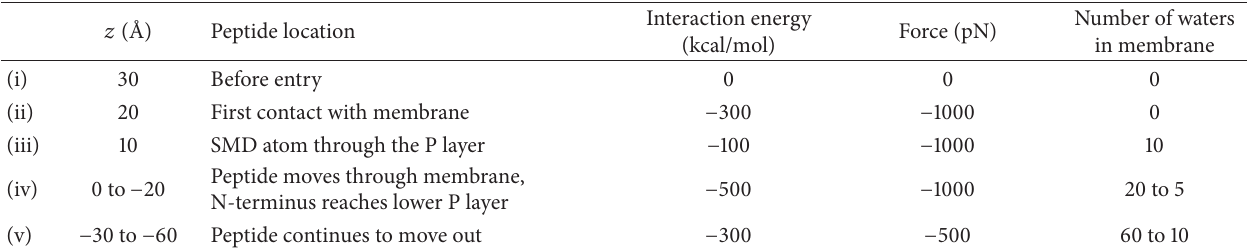
𝑧 (˚A) Peptide location Interaction energy